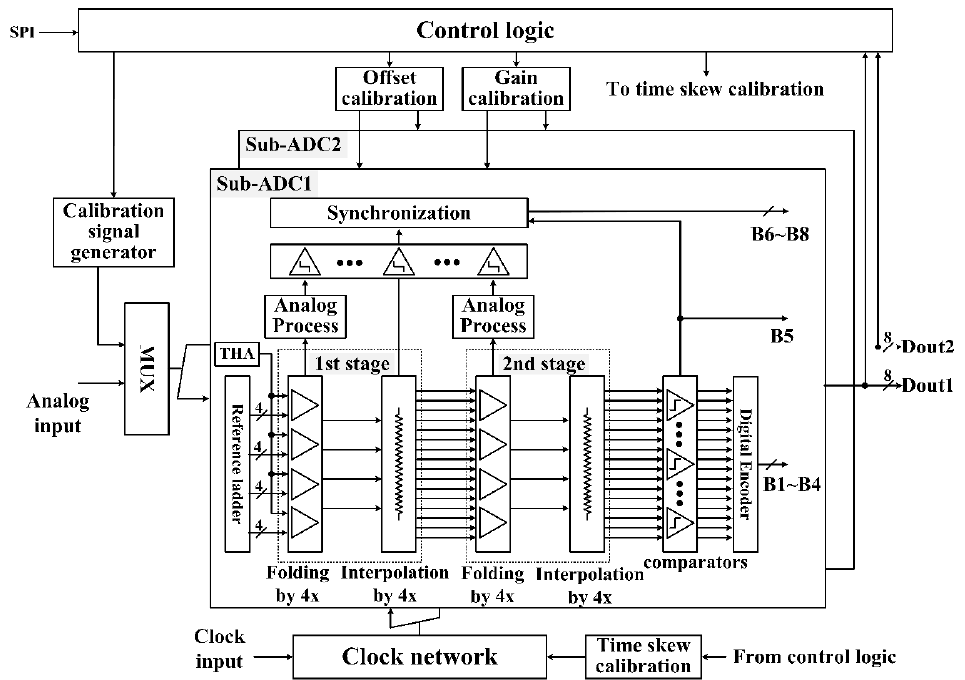
Figure 1. The block diagram of the analog-to-digital converter (ADC).